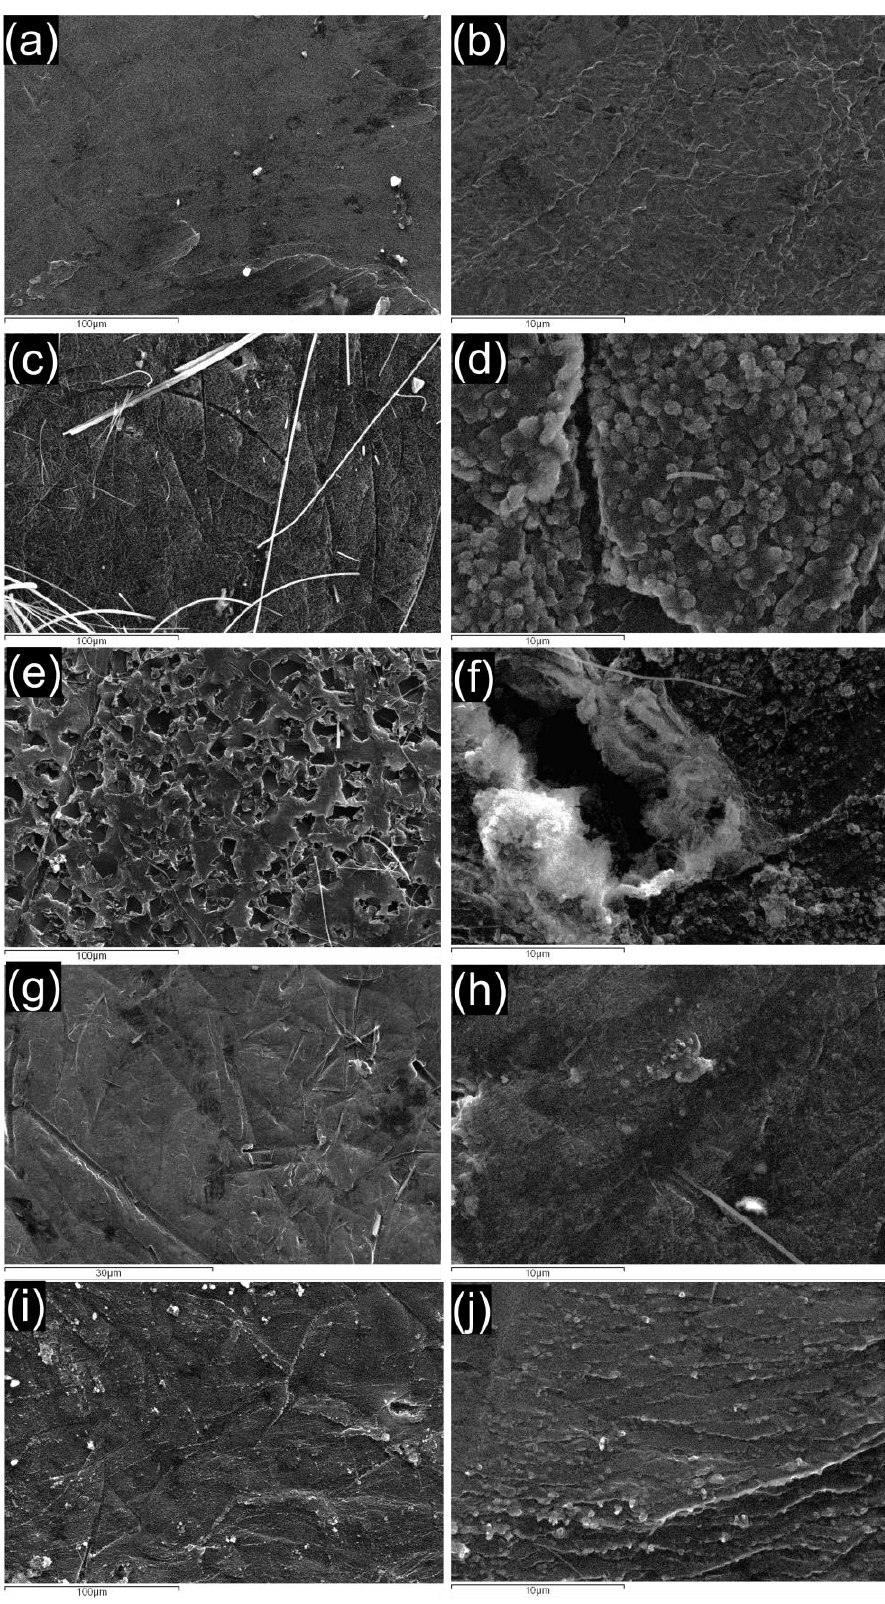
Figure 11. SEM images of pristine lithium ( a , b ) and cycled samples in ( c , d ) PC, ( e , f ) PC-NH 4 PF 6